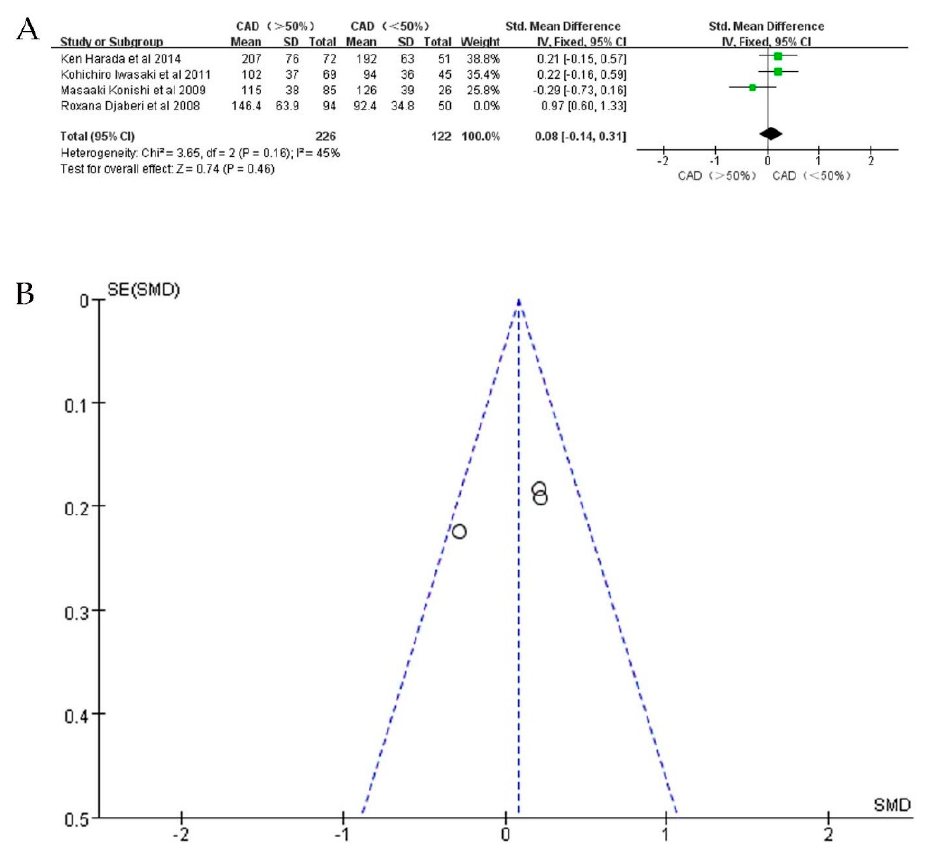
Figure 7. SMD of EAT volume between patients with severe CAD and mild/moderate CAD after sensitivity analysis. ( A ): Forest plot; ( B ): funnel plot.